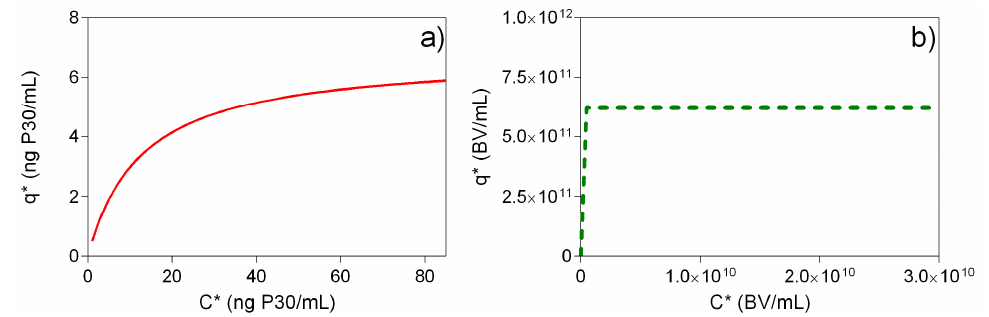
Figure 5. Equilibrium adsorption isotherm of VLP ( a ) and baculovirus ( b ) obtained with the estimated parameters in Table 1. A Langmuir adsorption isotherm ( q ∗ = q ) was considered. The equilibrium adsorbed concentration in the stationary phase is denoted by q ∗ , whereas c ∗ depicts the associated liquid phase equilibrium concentration Table 1. Best-fit values of the kinetic form of the Langmuir adsorption isotherm. The saturation capacity of the anion-exchanger is denoted by q sat (P30 ng mL − 1 or copies mL − 1 ), where K d and k 1 are the dissociation constant (ng mL − 1 or copies mL − 1 ) and the forward interaction rate constant (mL ng − 1 min − 1 or mL copies − 1 min − 1 ) of the adsorption model considered respectively.